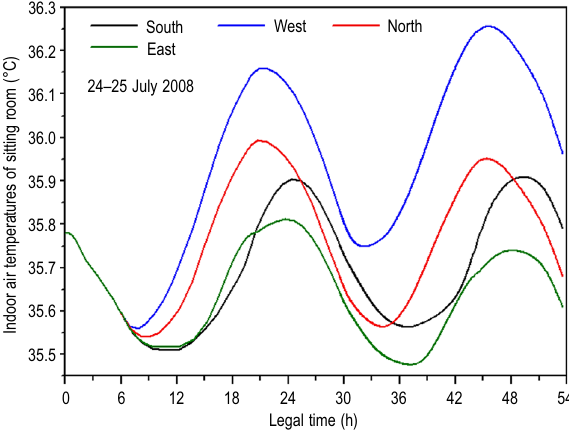
Fig. 9. Sitting room temperatures in the case of massive brick S/V ratio = 0.27, July 24 and 25, 2008